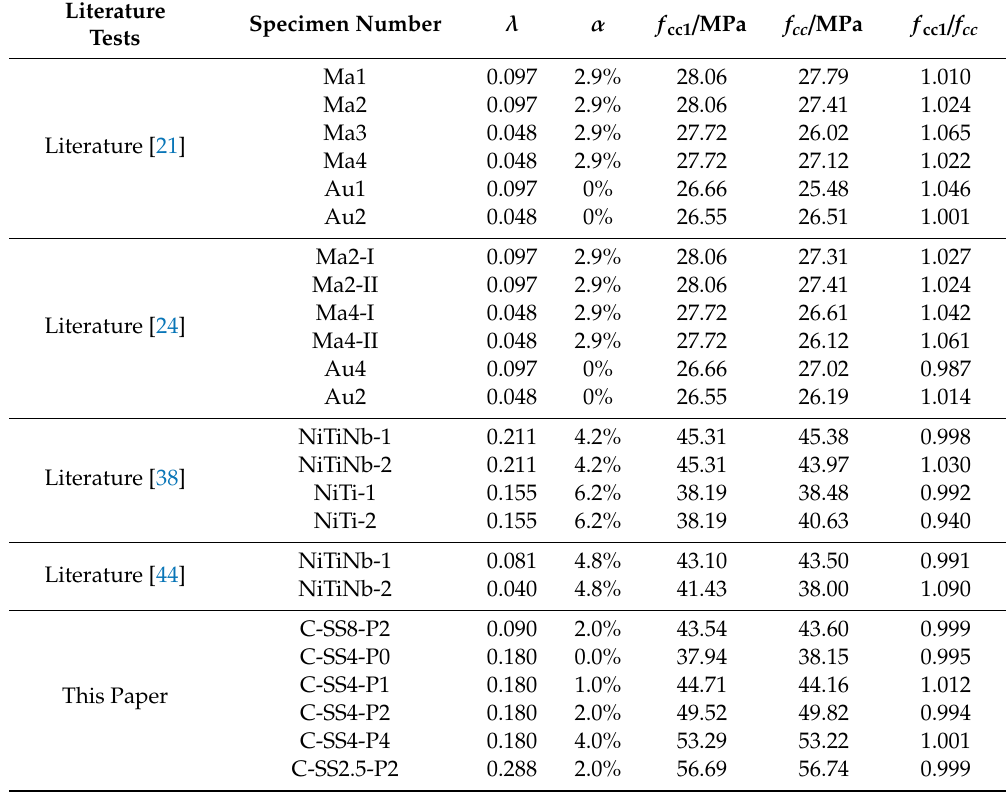
Table 6. Comparison of calculated and experimental values for concrete cylinder restrained by SMA